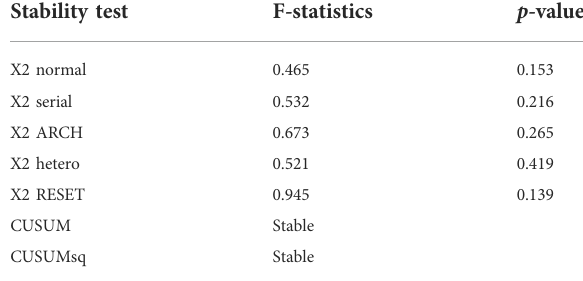
TABLE 4 BARDL co-integration analysis estimations (short-run). TABLE 5 Stability